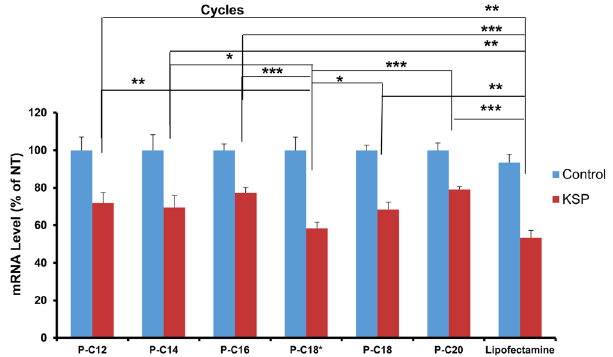
Figure 8. Quantification of down-regulation of KSP mRNA. Real-time PCR analysis of KSP expression (normalized based on beta actin) in AU-565 cells treated with scrambled (control) or KSP siRNA represented as mean + SD (n = 3), after 48 h of exposure to peptide/siRNA complexes (w/w ratio of 80:1; N/P ≈ 109) prepared with the modified peptides. The asterisks ( * , ** , *** ) represent significant difference at levels of P < 0.05, 0.01, and 0.001,